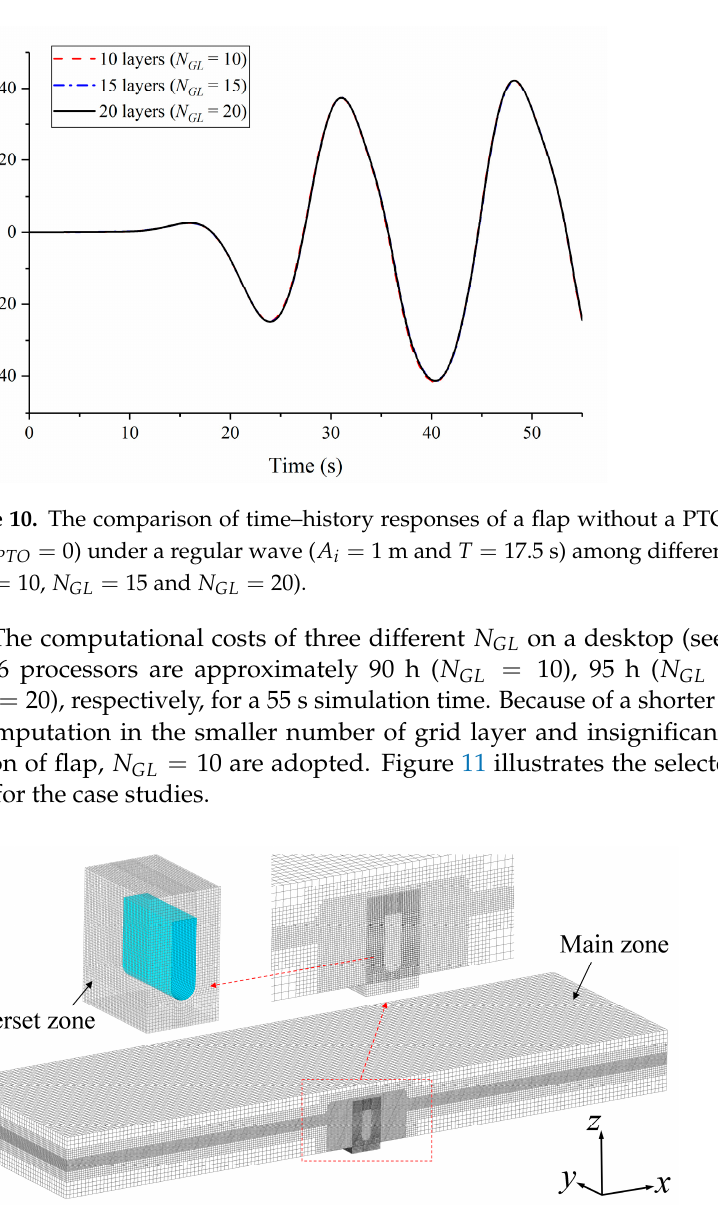
a overset zone, in which the flap (in blue) is restricted by a hinge. overset zone, in which the flap (in blue) is restricted by a